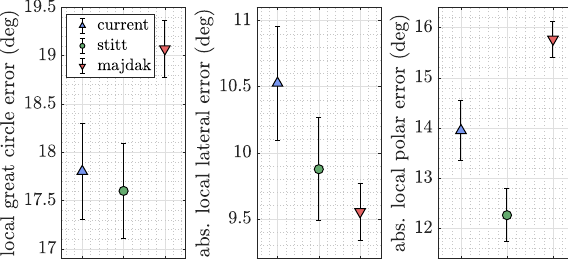
Figure 5. Comparison of participants performance during the No HMD condition and the performance plateaus reported in Stitt et al. [20] and Majdak et al. [14]. For the former, reported results are those of participants trained with individual HRTFs. For the later, reported results are those of their experiment 2, aggregating head and hand reporting methods. For both, only the trials after participants reached a performance plateau were considered, i.e. discarding the fi rst 1000 trials. The right-most fi gure reports absolute polar error values weighted according to the scheme presented in Section